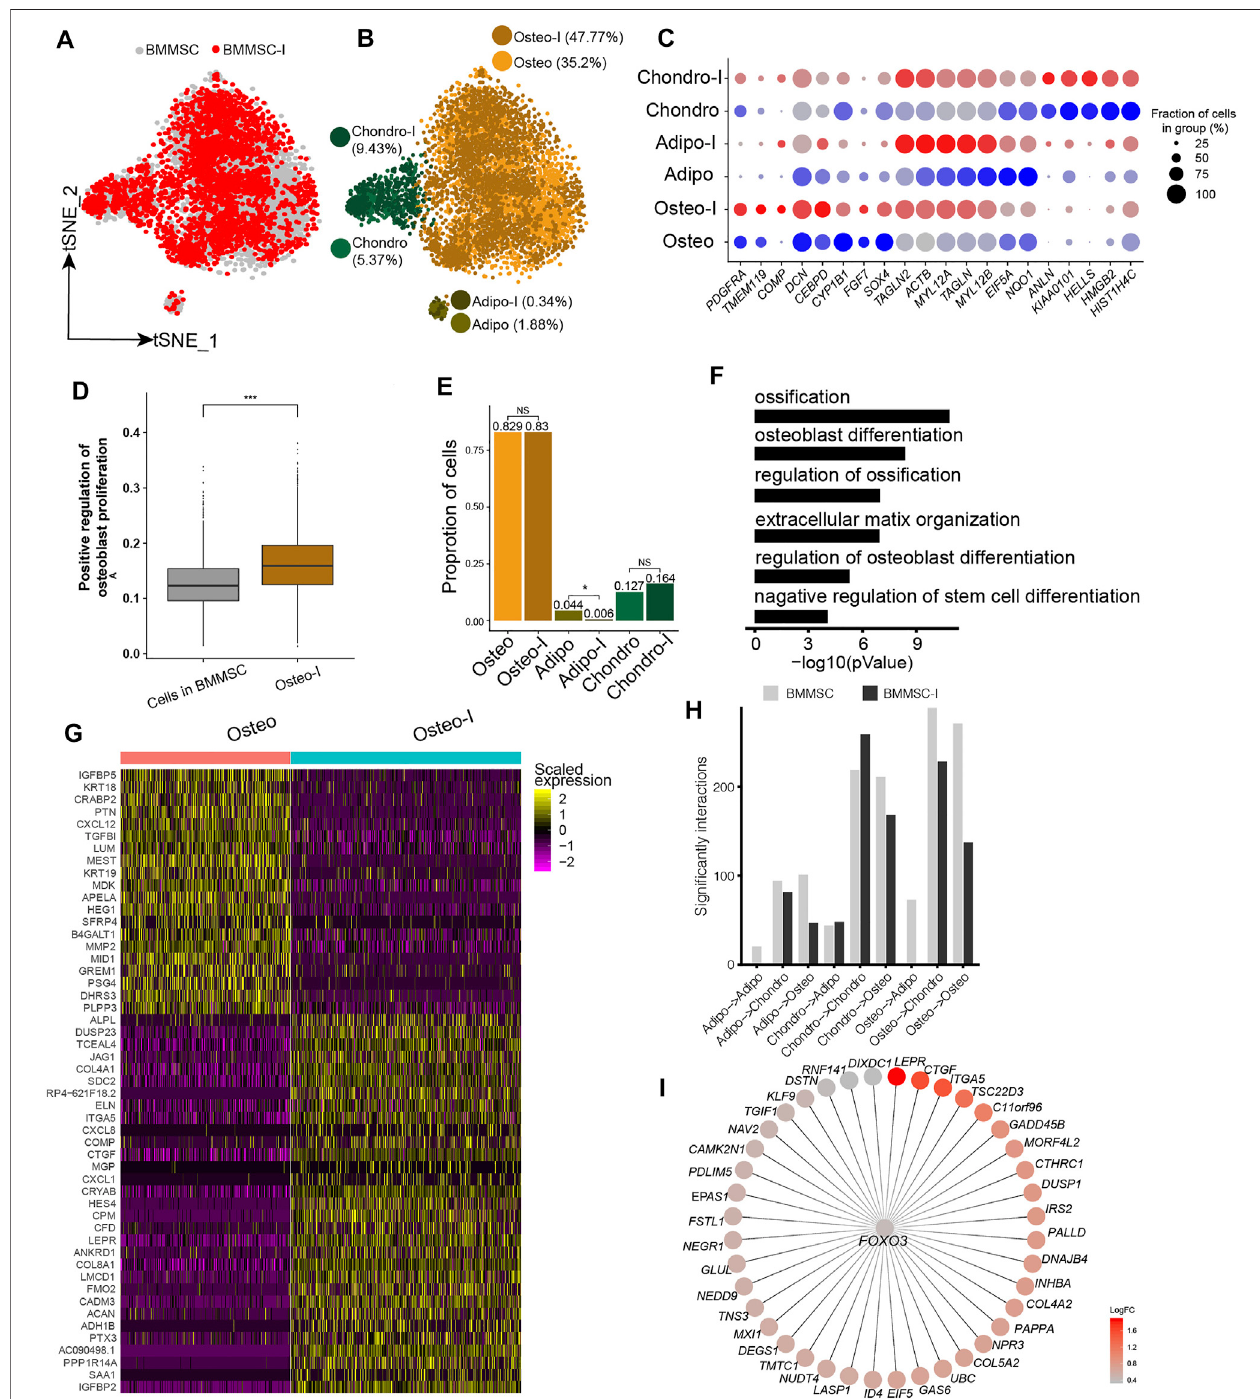
FIGURE 4 | Response heterogeneity and dynamics of MSCs to osteogenesis induction and its underlying mechanisms. (A) . t-SNE projection of MSCs pre-and post-osteogenesis induction, colored by non-induced BM-MSC (BM-MSCs) and osteogenic-induced MSCs (BMMSC-I). (B) . t-SNE projection of MSCs pre-and post- osteogenesis induction, colored by the six MSC subpopulations, namely chondro, osteo, adipo, chondro-I, osteo-I, and adipo-I. (C) . Dot plot of the expression level of lineage-speci fi cgenesin MSCsubpopulationspre- and post-osteogenesis induction. (D) .Boxplotofosteocyte differentiation scoresofcellsin BMMSC and post- inducedosteo(osteo-I).WilcoxonRankSumtest,*** p < 0.001. (E) .CellfractionsofMSCsubpopulationinBMMSCsandBMMSC-I.Fisher ’ sexacttest,* p -value < 0.05. (F) . The signi fi cantly enriched GO terms in osteo-I speci fi c genes compared to non-induced osteo. (G) . Heatmap of differentially expressed genes between pre- and post-induced osteo. (H) . Bar plot of signi fi cant interaction between MSC subpopulations pairs in BM-MSCs and BMMSC-I. (I) . FOXO3 and its target genes, with each target gene colored by log fold change between osteogenic-induced osteo and pre-induced osteo.